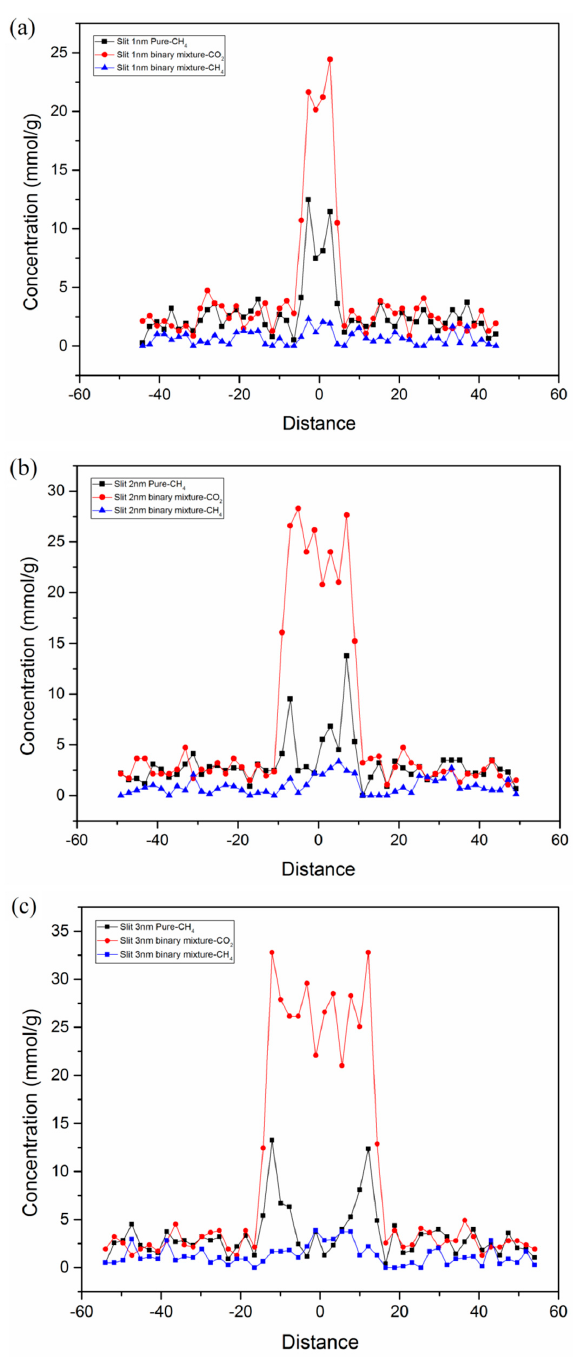
Figure 12. Concentration profile of pure CH 4 and a CO 2 / CH 4 binary mixture adsorption in slit kerogen nanopores: ( a ) 1 nm; ( b ) 2 nm; ( c ) 3 nm (partial pressures of CO 2 and CH 4 were 10 MPa and 5 MPa, respectively; T = 298